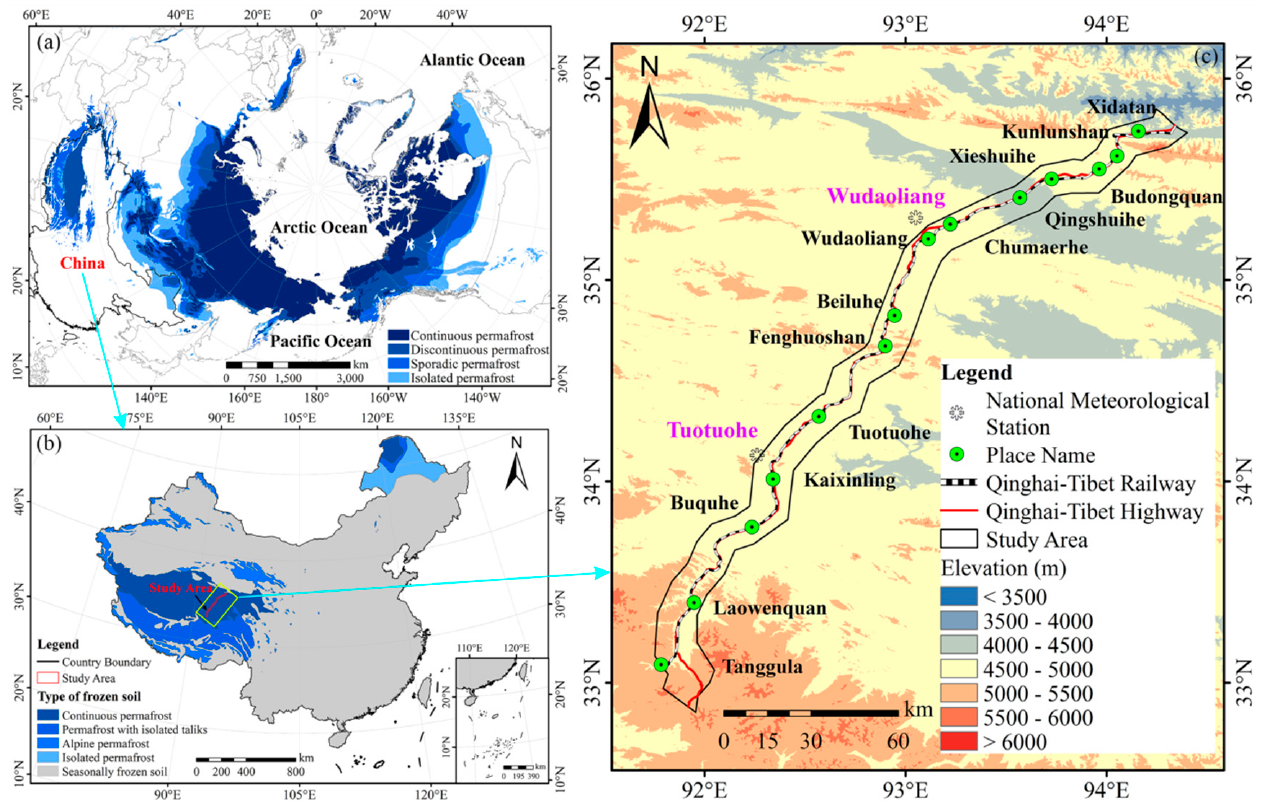
Figure 1. ( a ) Circum-Arctic permafrost map. The data in this permafrost map was derived from National Snow and Ice Data Center (https://nsidc.org/data/GGD318/versions/2, accessed date: 15 January 2020). ( b ) Distribution of permafrost in China [57]. ( c ) Geographical location of the study area.